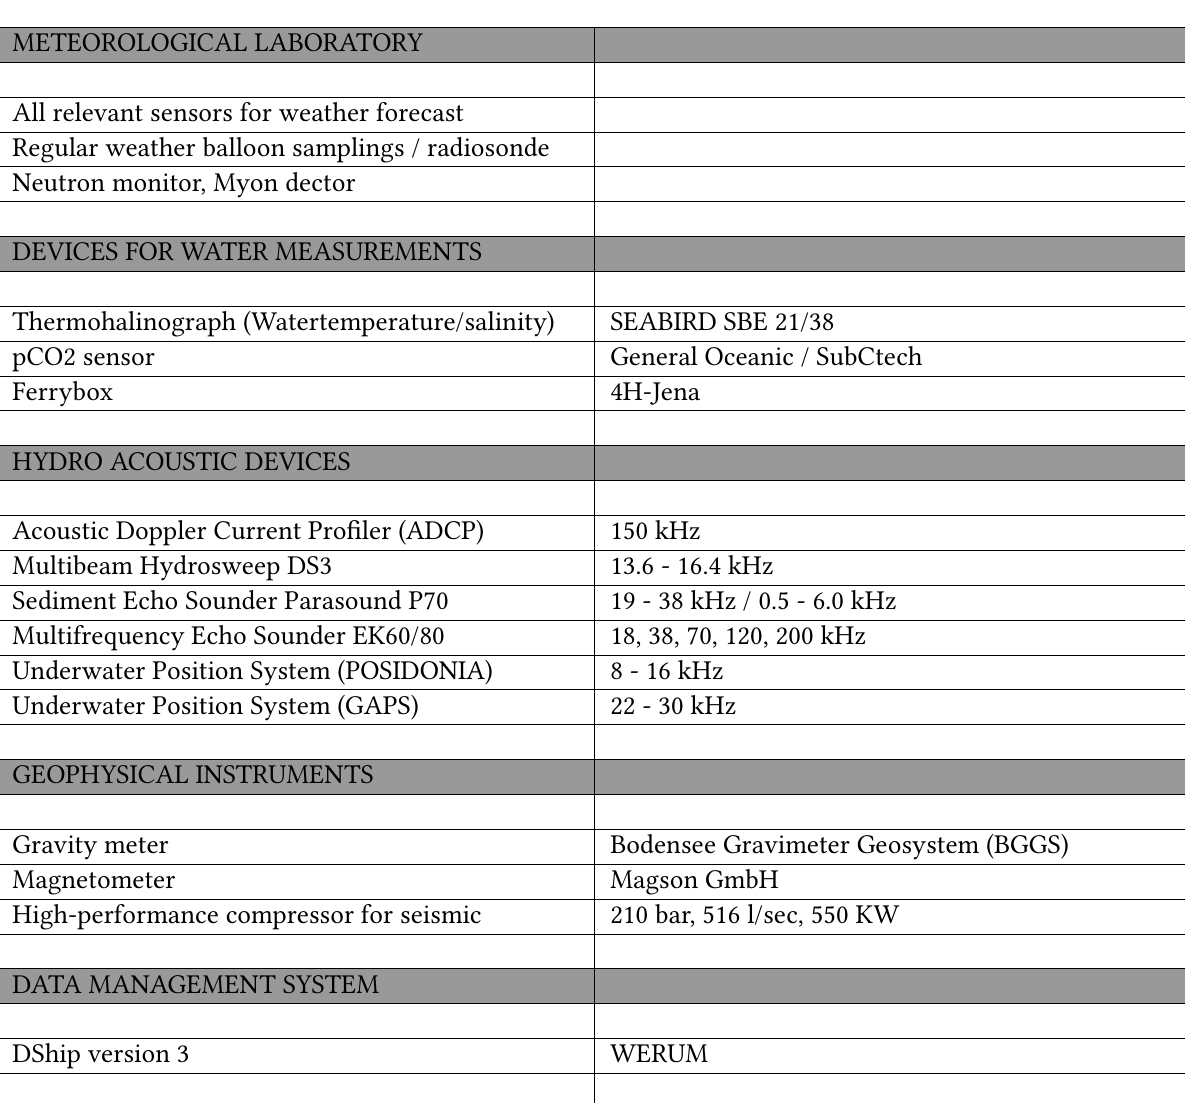
Table 3: Scientific devices and data management systems installed on board